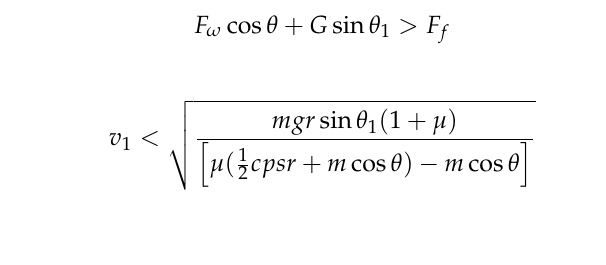
Figure 5. Schematic diagram of the force analysis of the separation of the residual film and blade. Note: F a is the air resistance of the residual film, N ; F ω is the centrifugal force on the residual film, N ; G is the gravity of the residual film, N ; F N is the supporting force of blade to residual film, N ; F f is the friction force of the residual film, N ; θ is the inclination angle of the detached blade, ( ◦ ); θ 1 is the angle between the gravity of the residual film and the vertical direction of the detached blade, ( ◦